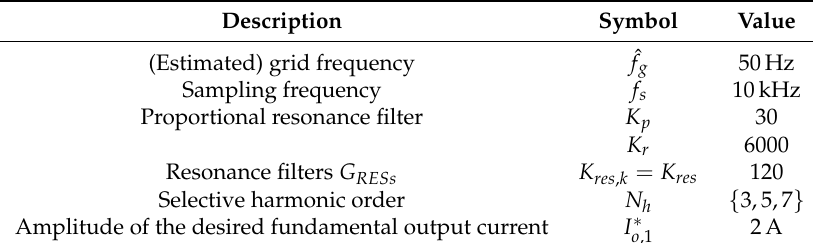
Table 2. Default parameters of the control